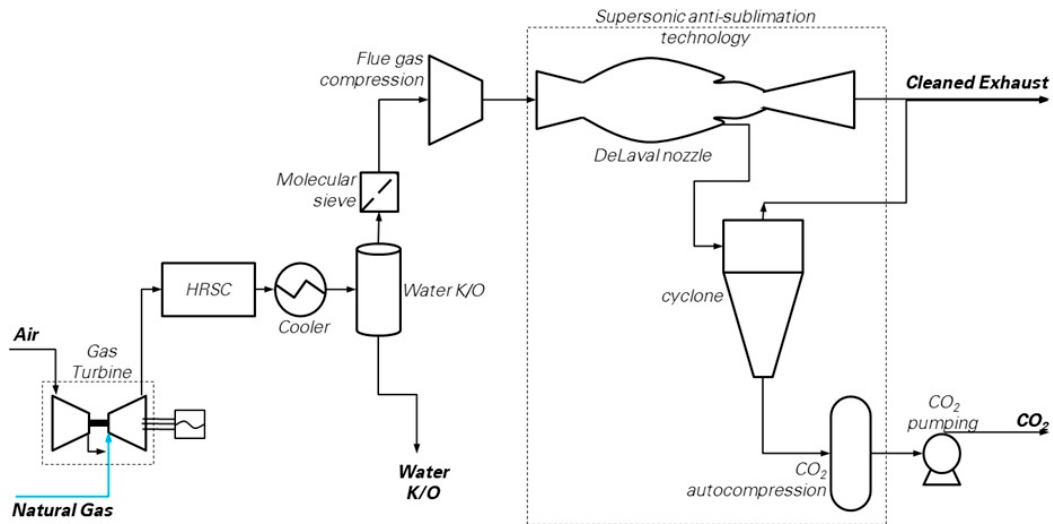
Figure 6. CO 2 capture by supersonic flow-driven deposition (SSD) [25]. (Picture reprinted